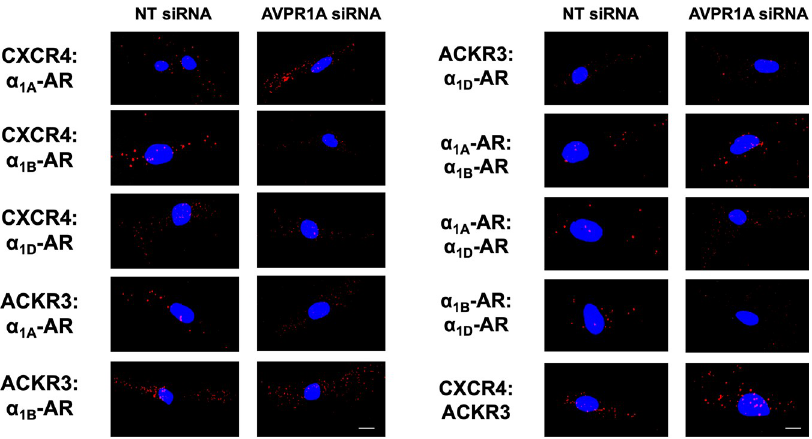
Fig 8. Detection of heteromers between α 1A/B/D -ARs, CXCR4, and ACKR3 upon depletion of AVPR1A in hVSMCs. Representative PLA images for the detection of receptor-receptor interactions in hVSMC after incubation with non-targeting (NT) siRNA or AVPR1A siRNA. Images show merged PLA/4 0 ,6-diamidino-2-phenylindole dihydrochloride (DAPI) signals. Scale bar = 10 μ m.